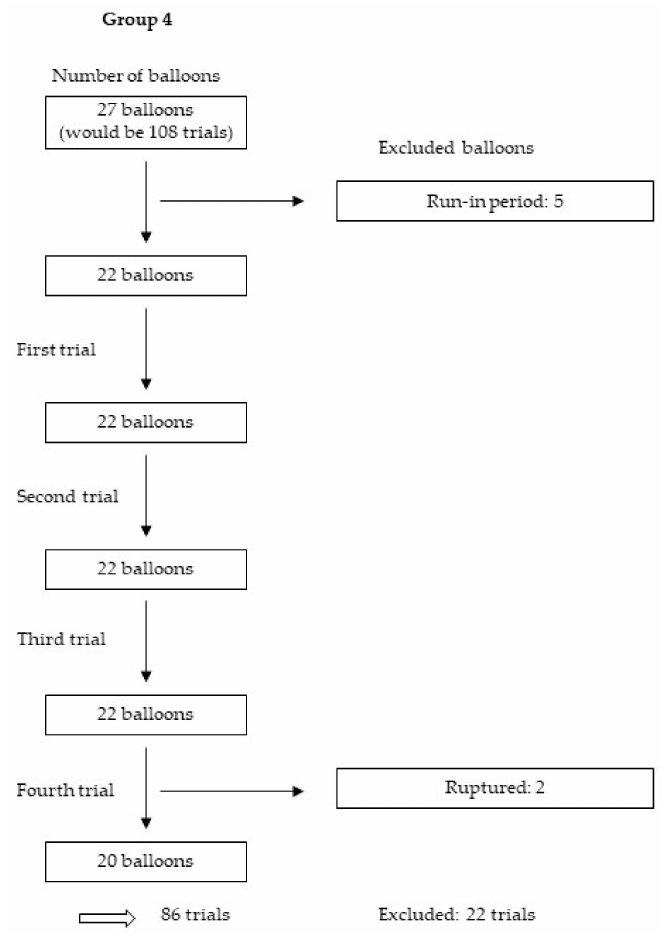
Figure 8. Excluded balloons group 4.